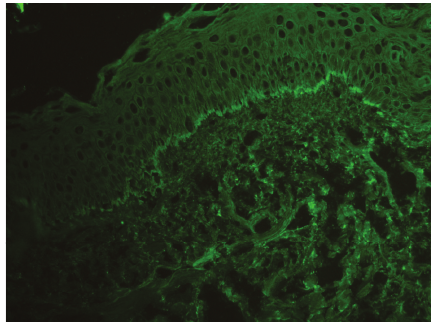
Figure 4: Direct immunofluorescence photomicrograph showing linear band of poor IgG deposition along the basement membrane zone ( ×